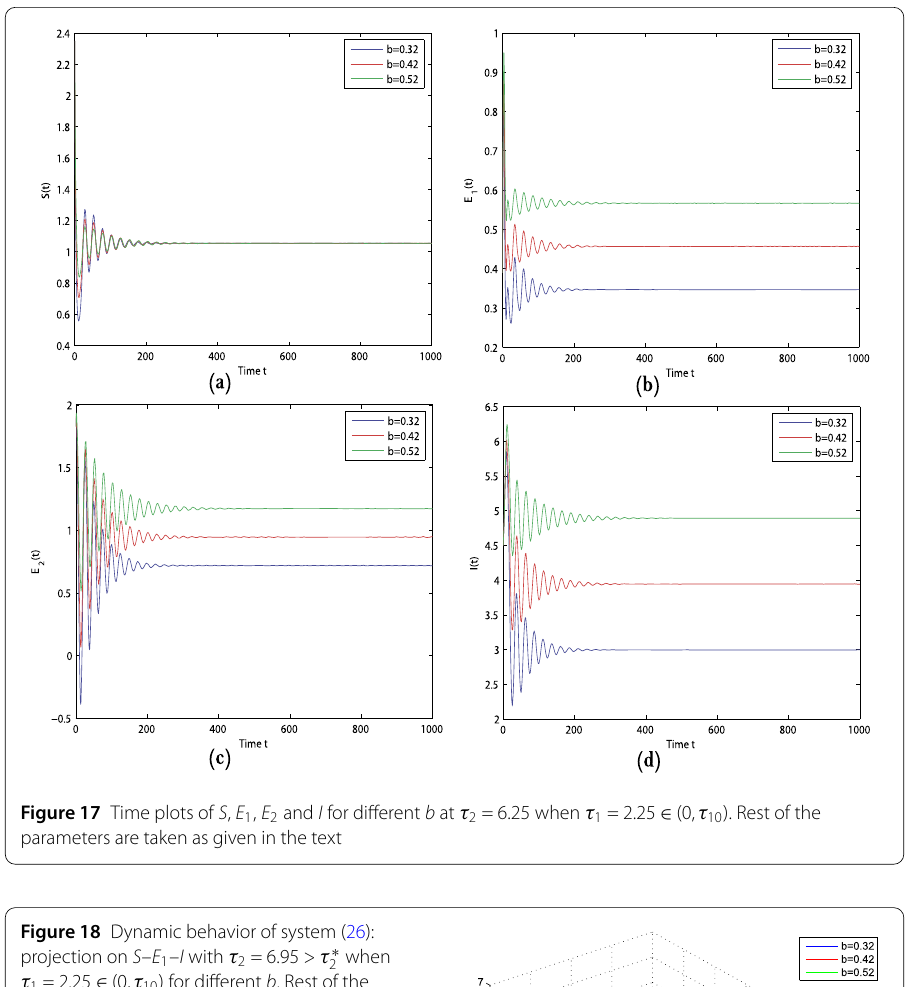
Figure 18 Dynamic behavior of system (26): projection on S – E 1 – I with τ 2 = 6.95 > τ ∗ 2 when τ 1 = 2.25 ∈ (0, τ 10 ) for different b . Rest of the parameters are taken as given in the